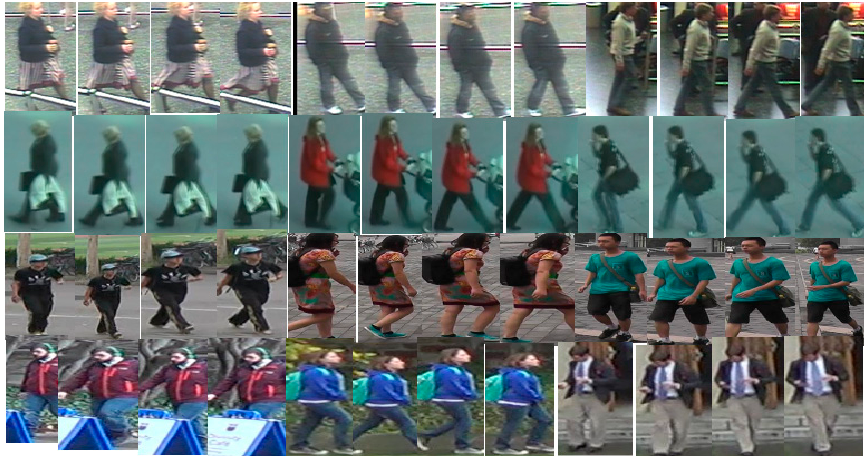
Figure 6. A Sequence of Person Tracklets from Different Datasets.